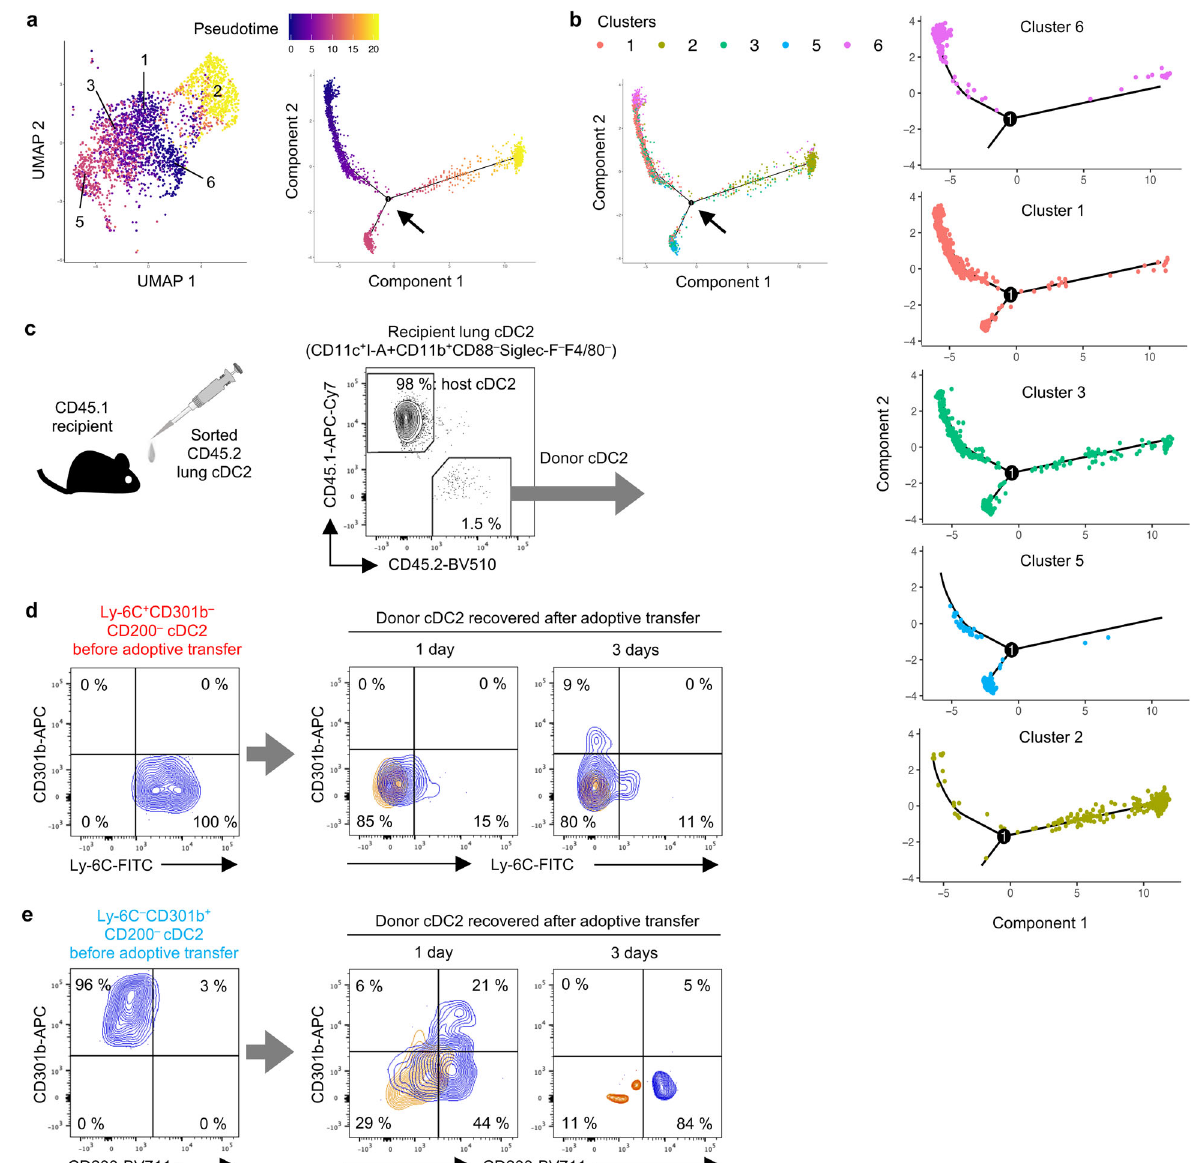
Fig. 7 Maturation of cDC2 subpopulations. a Pseudotime analysis (Monocle) of maturation pathways for fi ve cDC2 clusters. A proposed developmental progression is indicated by different colors in the UMAP (left) or the trajectory plot (right) including a branching point for Ly-6C + and Ly-6C – cells. b Pseudotime-suggested developmental trajectory for fi ve cDC2 clusters (1, 2, 3, 5, and 6). The clusters are color-coded, and a branching point (arrow) for Ly-6C + and Ly-6C – cells is indicated by an arrow or circled 1. A combination of all fi ve clusters is shown (left panel), as well as trajectories for individual clusters (right panels). c Puri fi ed cDC2 subsets from C57BL/6 (CD45.2) were adoptively transferred to C57BL/6-CD45.1 mice. CD45.2 + donor-cDC2- derived cells were analyzed by fl ow cytometry. The gating strategies for cell sorting and analysis in fl ow cytometry are shown in Supplementary Fig. 13a, b. d , e Flow cytometric analysis of Ly-6C + CD301b – CD200 – ( d ) or Ly-6C – CD301b + CD200 – ( e ) before and 1 day and 3 days after adoptive transfer. Blue and orange counter plots show cells stained with speci fi c Abs and isotype controls, respectively. A representative result from two independent experiments is